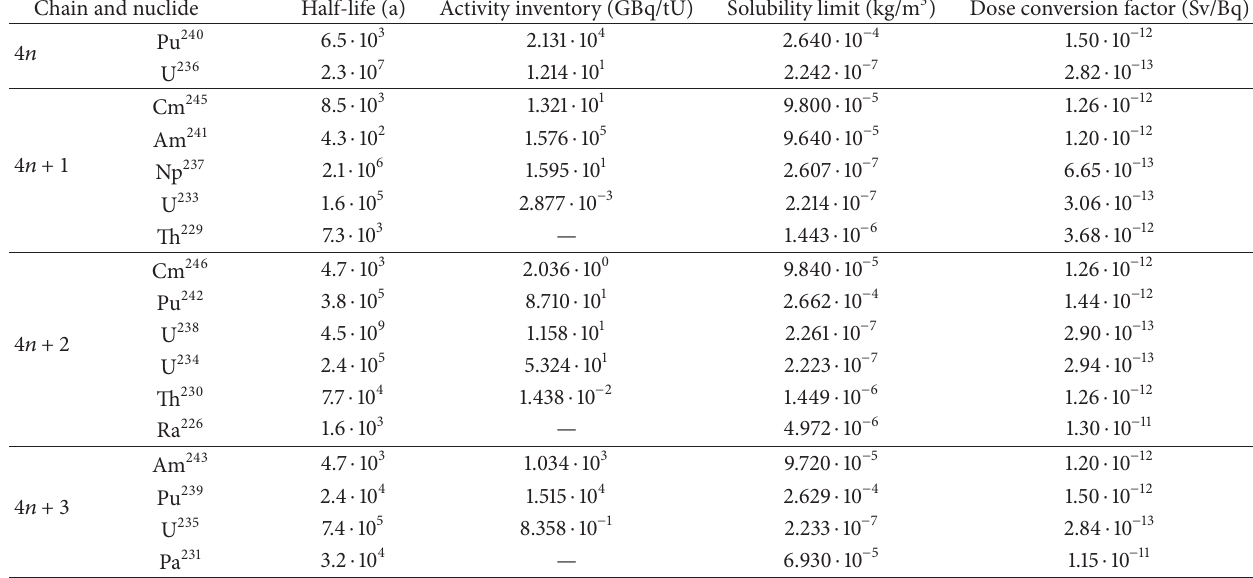
Table 4: Radionuclide chain decay data.